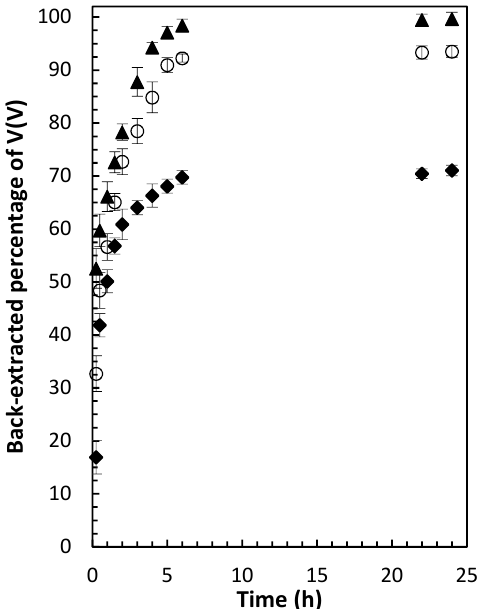
Figure 7. Back-extracted percentage of V(V) from PIMs (50 wt% PVDF-HFP, 40 wt% Aliquat ® 336 and 10 wt% DBP, 33.5 mg V(V)/g PIM) using sulfuric acid solutions (1.0 , 3.0 ○ and 6.0 ▲ mol L −1 ) containing 1 v / v % H 2 O 2 as a function of time. PIMs/aqueous back-extraction solution contact time and temperature were 24 h and 22 ± 1 °C, respectively. Error bars = ± SD.